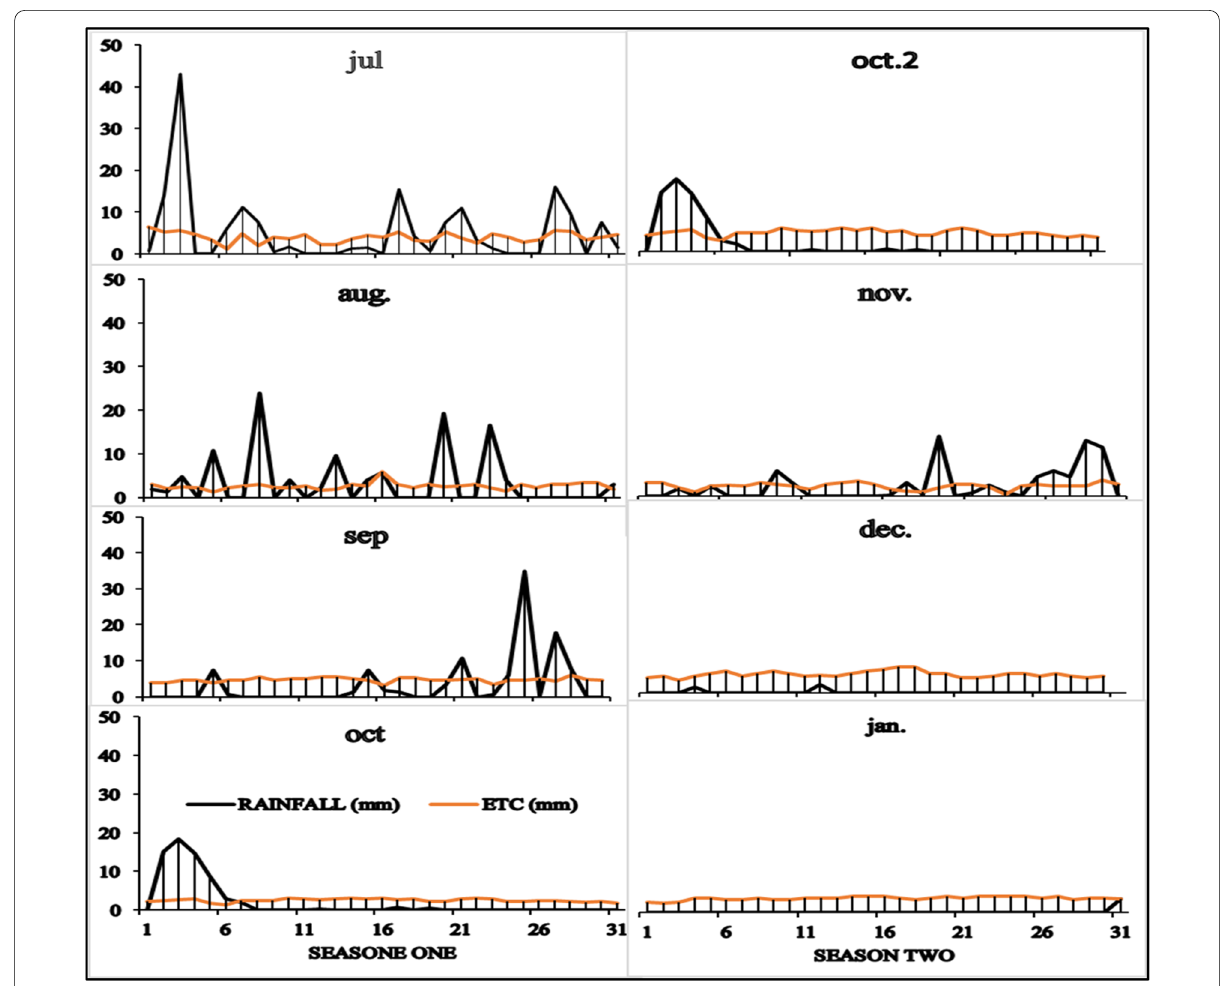
Fig. 1 Daily precipitation and ET c of the growing seasons